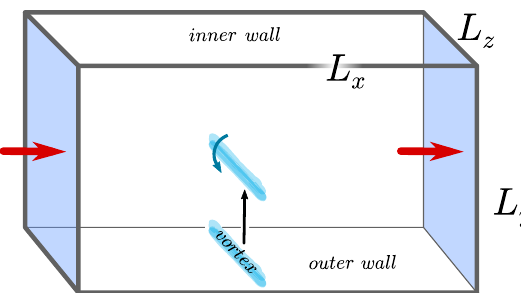
Figure 1. Sketch of the annulus considered by Wexler [21]: periodic boundary conditions are imposed on the two shaded faces, that have no walls. The two red arrows indicate the direction of the uniform background flow along the circumference L x (since L x (cid:29) L y , this background flow is almost uniform, at least far from the vortex). An intermediate displacement of the vortex (that from the outer wall is slowly dragged towards the inner wall) is also shown. The vorticity is directed out of the page, in accordance with the sketched direction of the induced flow around the